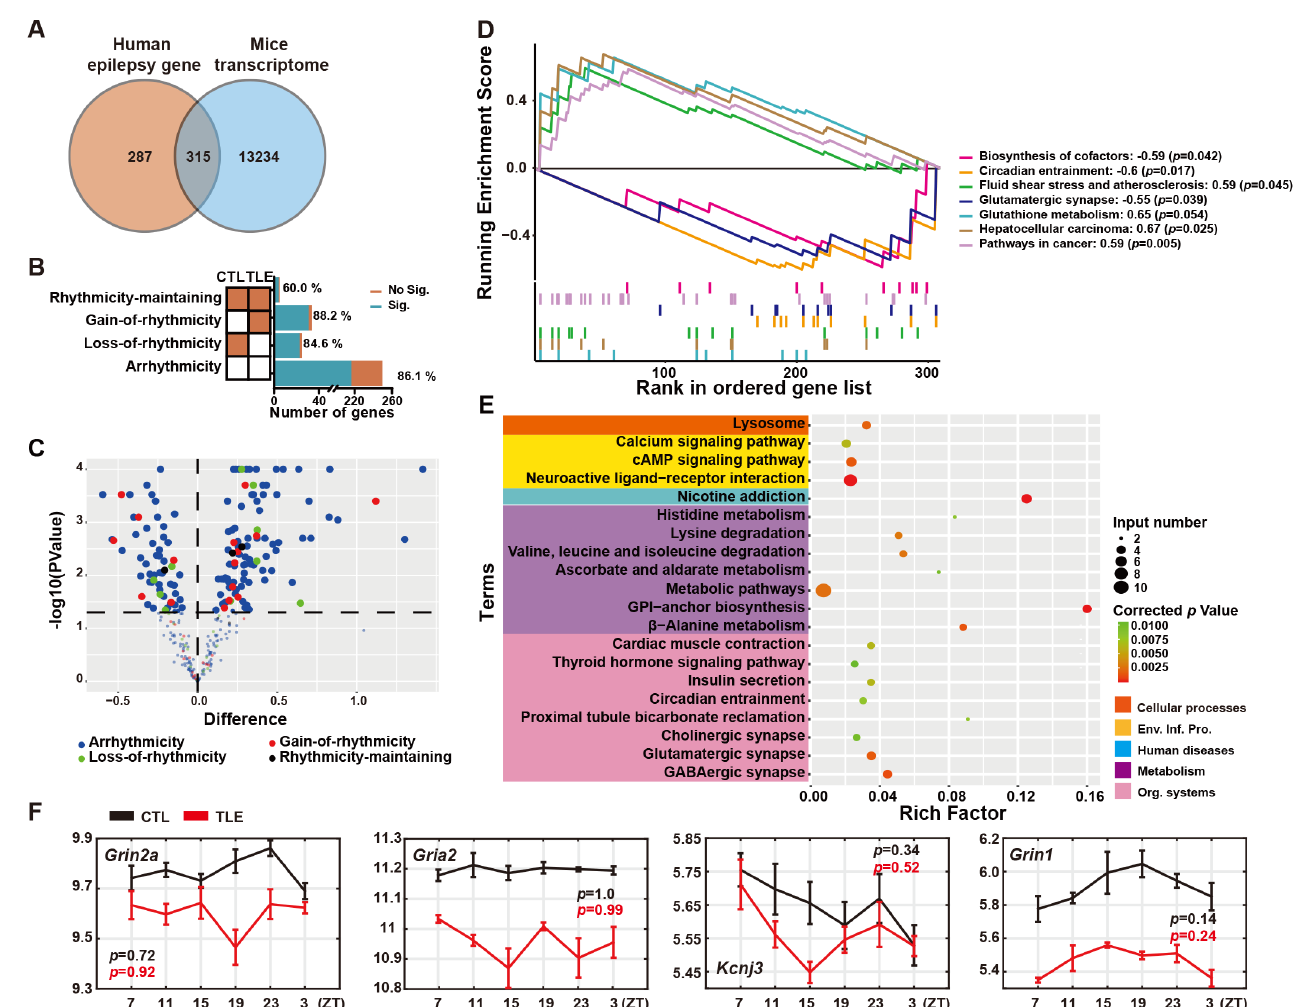
Figure 1. Analysis of mouse epileptic genes. ( A ) Venn diagram of 315 epilepsy-related genes in the ventral hippocampus of mouse temporal lobe epilepsy (TLE). ( B ) Classification of 315 possible mouse epilepsy-related genes into 251 arrhythmic genes, 25 loss-of-rhythmicity genes, 34 gain-of-rhythmicity genes, and five rhythmicity-maintaining genes. Shown are percentages of significantly differentially expressed genes between TLE and CTL groups (blue) and not significantly differentially expressed genes (orange). ( C ) Volcano plot of up-regulated and down-regulated genes in arrhythmicity, loss-of-rhythmicity, gain-of-rhythmicity, and rhythmicity-maintaining groups at the seizure peak time (ZT7) of mouse TLE. ( D ) Gene set enrichment analysis (GSEA) of significantly altered KEGG pathways in 315 epilepsy-related genes at ZT7. The rank of the gene set of each pathway is listed on the right side of the plot. Four pathways show positive enrichment scores, and three show negative enrichment scores. ( E ) Top 20 KEGG enrichment pathways of 79 mouse epilepsy driver genes. Circles represent the gene numbers in specific pathways and colored intensities the corrected p values. The first-level categories of KEGG pathways are marked in different colors. ( F ) Expression of representative arrhythmic genes involved in the circadian entrainment and glutamatergic synapse pathways simultaneously, including Grin2a (Glutamate ionotropic receptor NMDA type subunit 2A), Gria2 (Glutamate ionotropic receptor AMPA type subunit 2), Kcnj3 (Potassium inwardly rectifying channel subfamily J member 3), and Grin1 (Glutamate ionotropic receptor NMDA type subunit 1). The black curve represents gene expression values from the CTL mice, and the red curve is for those in TLE